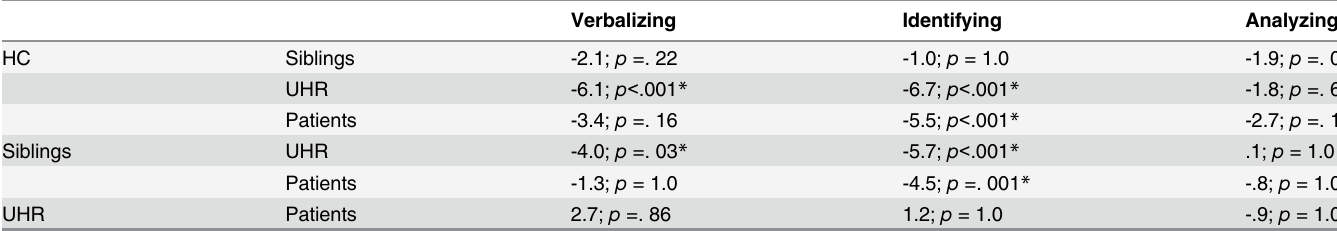
Table 3. Post-hoc results (mean difference and p -value) of group differences on the cognitive alexithymia subscales. Verbalizing Identifying